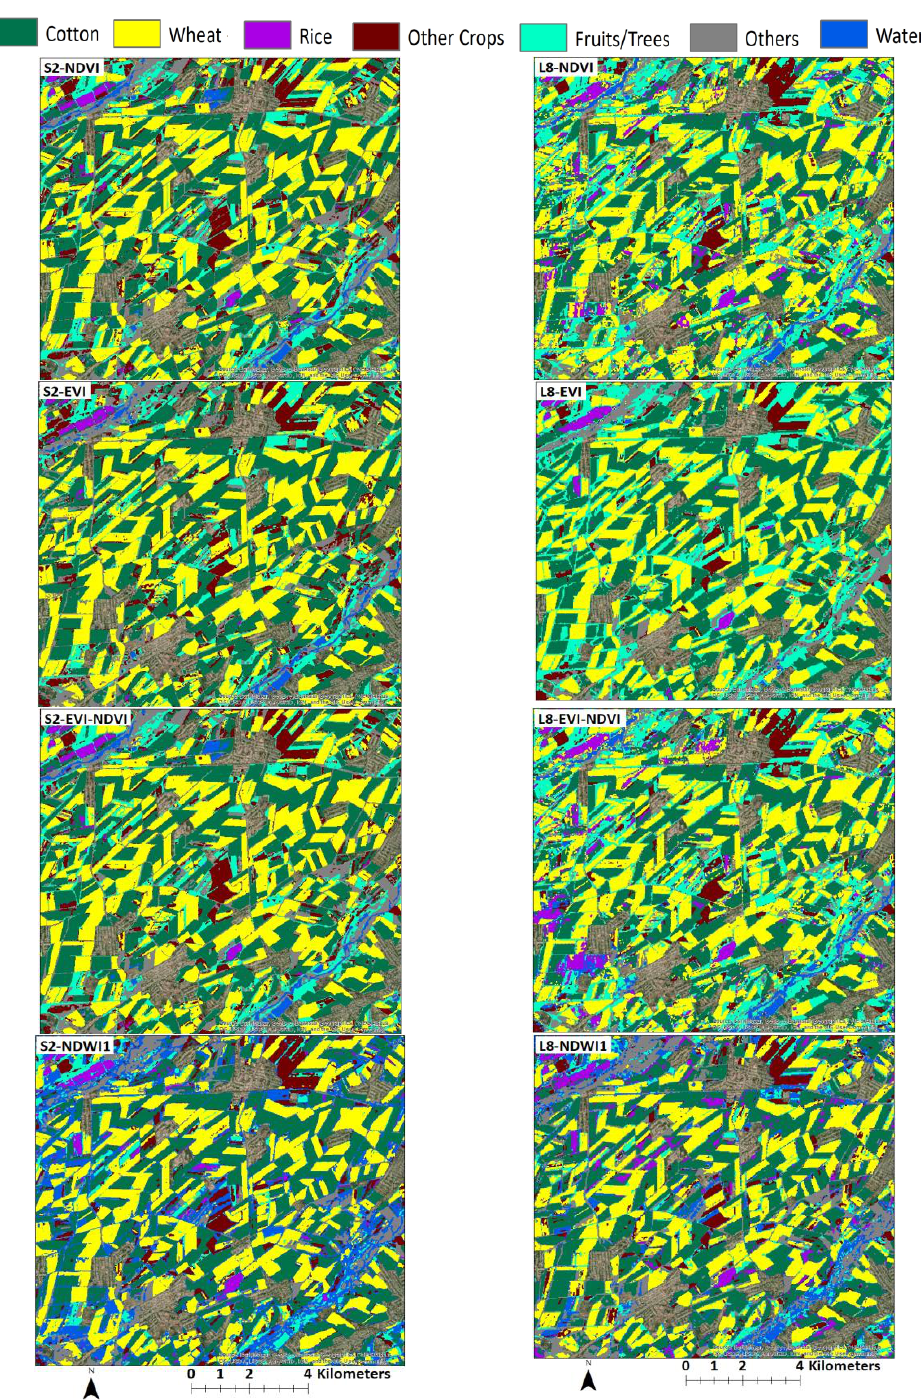
Figure 10. Subsets of land use maps derived from different indices using the SVM classification method for both S2 ( left ) and L8 ( right ).